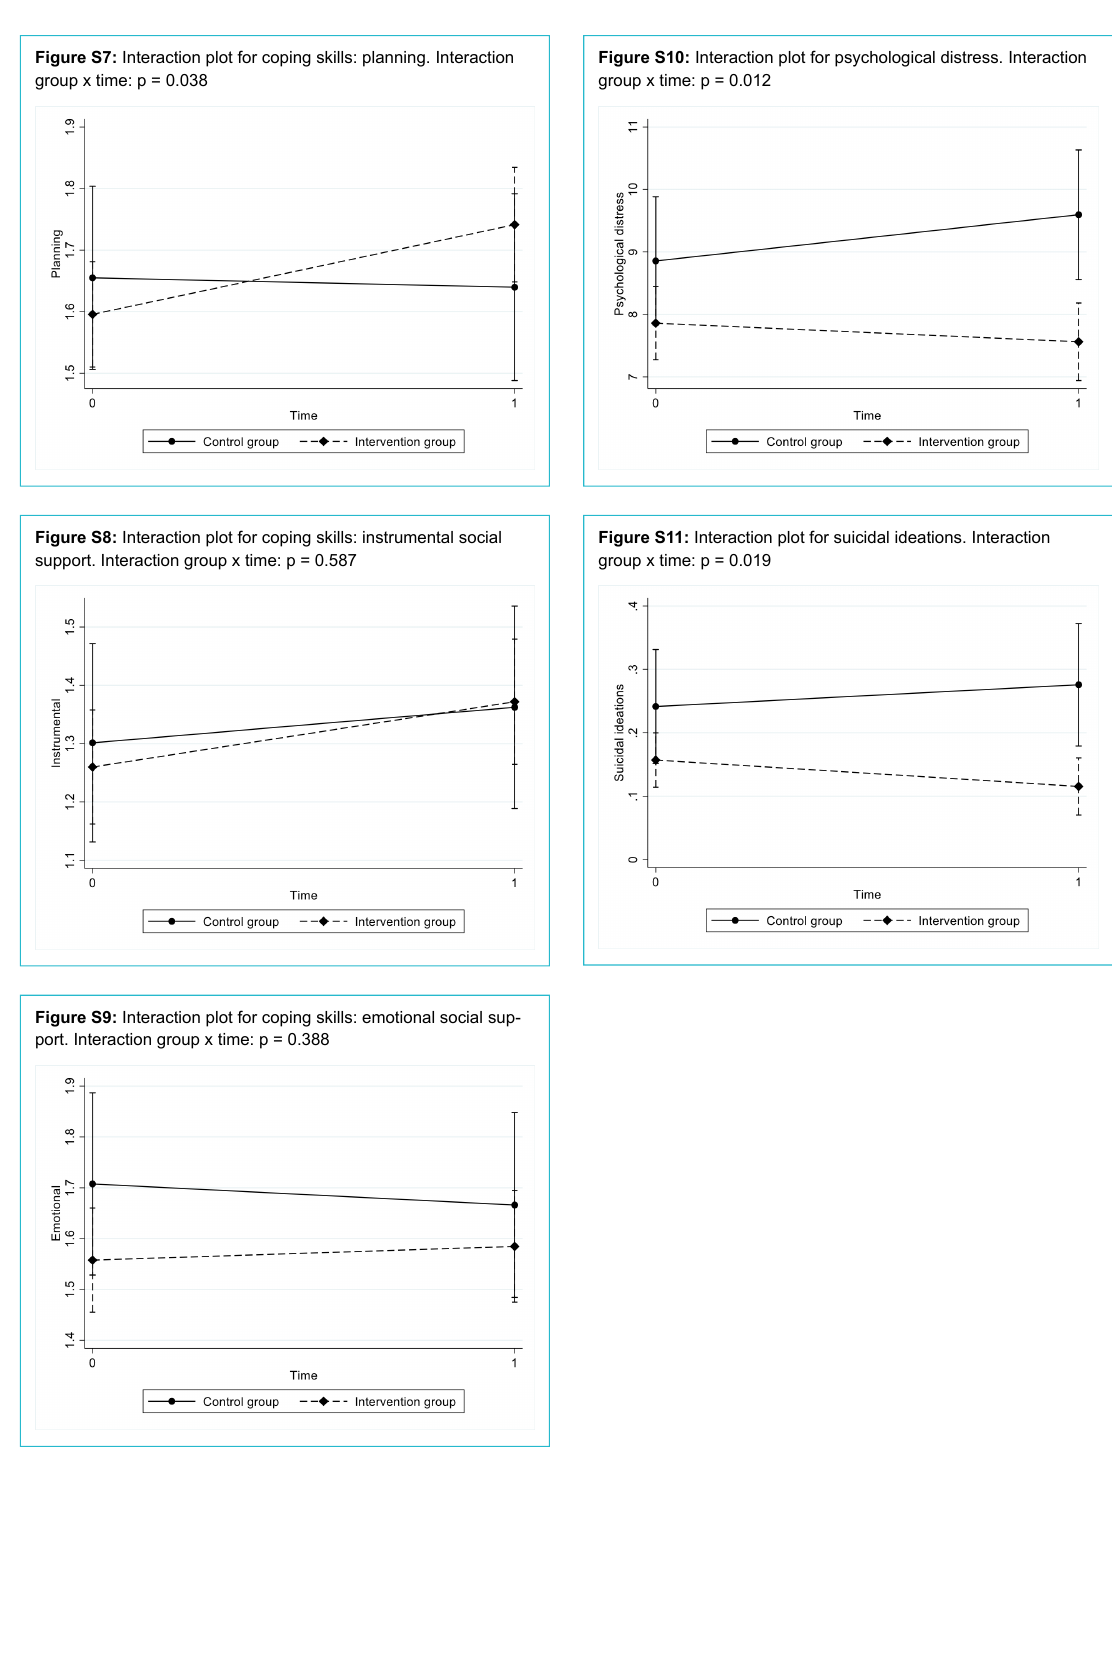
Figure S7: Interaction plot for coping skills: planning. Interaction group x time: p = 0.038